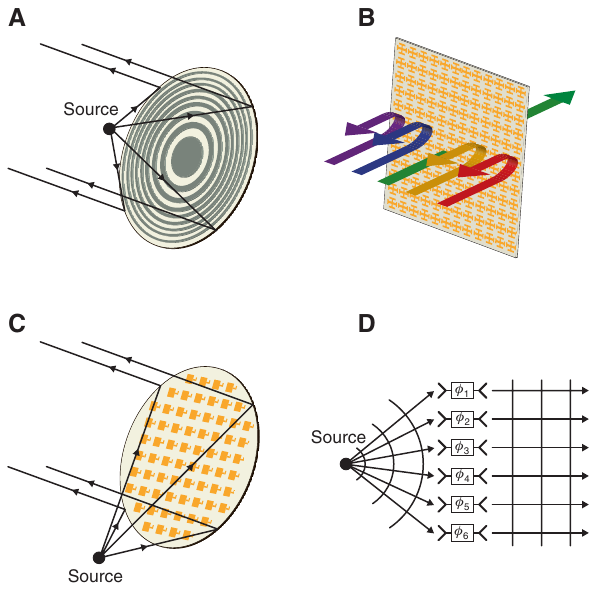
Figure 1: Examples of two-dimensional wave manipulating struc- tures: (A) Fresnel zone plate reflector, (B) reflectarray, (C) intercon- nected array lens, and (D)